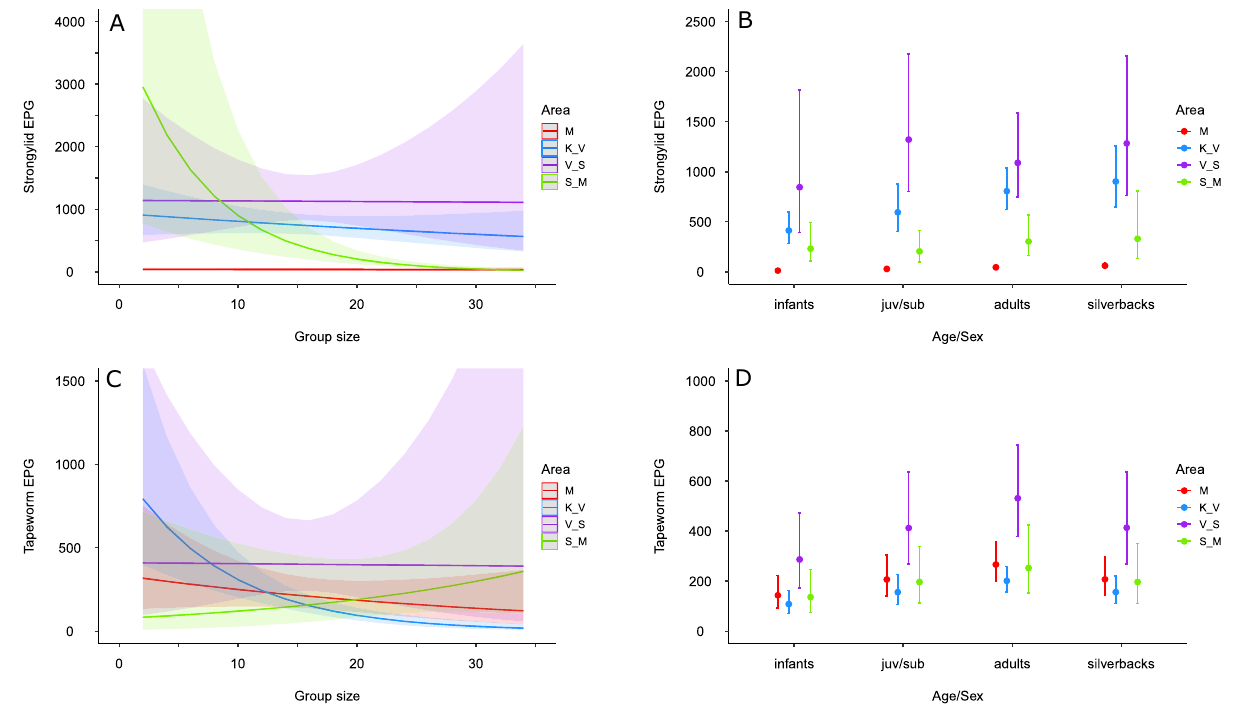
Figure 4. Models’ predicted mean values with 95% confidence intervals for the factors affecting helminth infections in mountain gorillas in Virunga Massif in two periods (dataset 2). ( A ) strongylid egg per gram (EPG)—sampling area and group size effects, ( B ) strongylid EPG—sampling area and age/sex class effects, ( C ) tapeworm EPG—sampling area and group size effects, ( D ) tapeworm EPG—sampling area and age/sex class effects. juv/sub: juvenile/subadult class; M: Mikeno (Virunga National Park); K_V: Karisimbi–Visoke (Volcanoes National Park), V_S: Visoke–Sabyiniyo (Volcanoes National Park), S_M: Sabyinyo–Muhavura